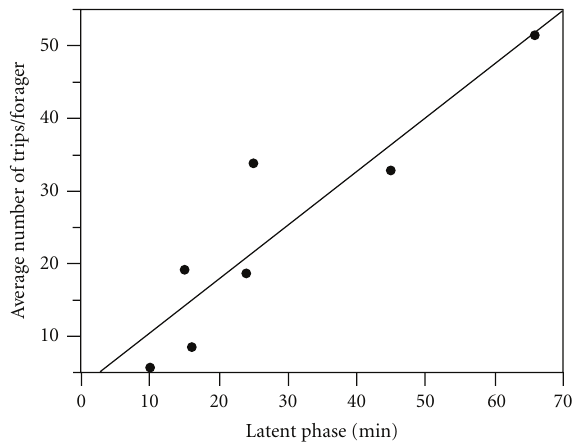
Figure 5: Average number of trips/forager for marked foragers ar- riving at the training station during the pretesting and testing phases as a function of the duration of the latent